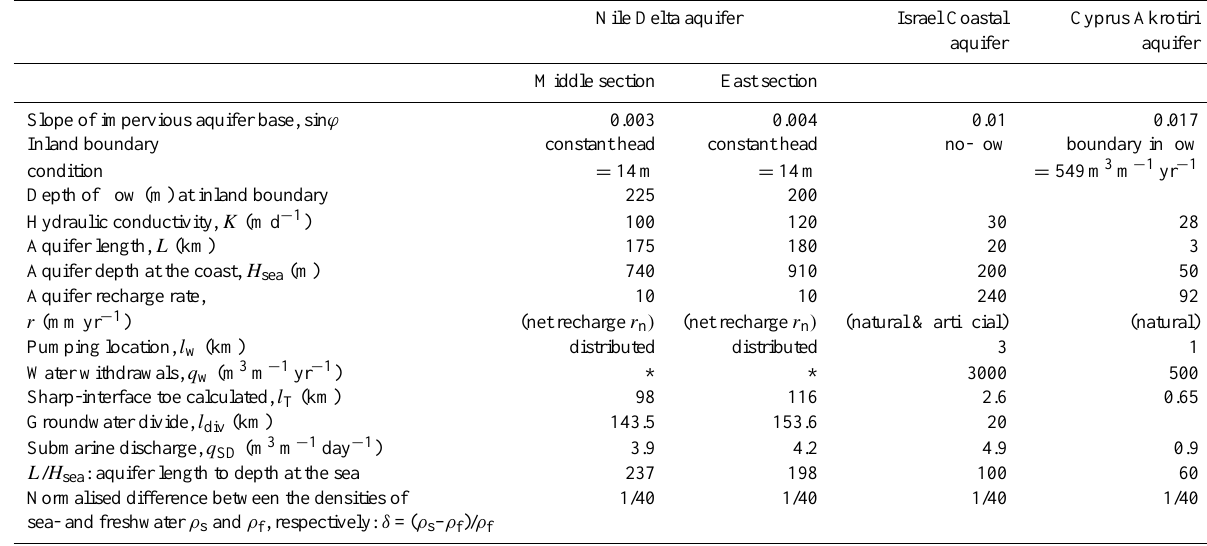
Table 1. Characteristics and parameters of the conceptual model sections (Fig. 3) of the three Mediterranean aquifers. Nile Delta aquifer Israel Coastal Cyprus Akrotiri aquifer aquifer Middle section East section Slope of impervious aquifer base, sin ϕ 0.003 0.004